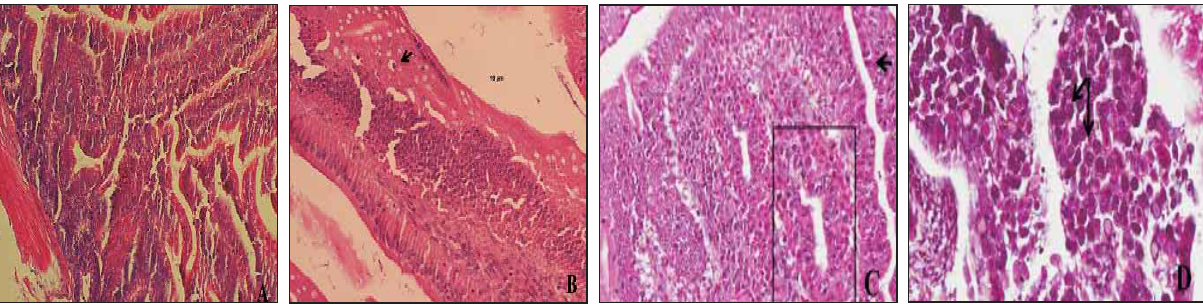
Figure-6: Chicken duodenal sections stained with H&E of birds infected with oocysts (1.0x10 sporulated oocyst/chick) showing: oocyst's developmental stages in the duodenum cells. (A) Photomicrograph of a duodenum from broiler chicken of the control. Normal duodenum can be seen. x200; (B) Photomicrograph of a duodenum from a broiler at 72 h PI: presence of second schizonts and young macrogametocyte in the striated chicken inoculated with border cells of villi. (H&E, bar=10 x400; (C) Photomicrograph of a duodenum from a broiler chicken inoculated with at 96 h PI: presence of immature gametocytes in intestine cells. (H&E) x400; (D) Photomicrograph of a duodenum from a broiler chicken inoculated with at 120 h PI: great multiplication of micro and macrogametocytes, oocysts, zygotes, fourth generation schizonts in the middle and beginning of crypts and hyperplasia up to the tip level of villi. (H&E), x400. (E) Photomicrograph of a duodenum inoculated with at 120 h PI: x400 extension (x4). Arrow indicates different forms of the intracellular parasite.